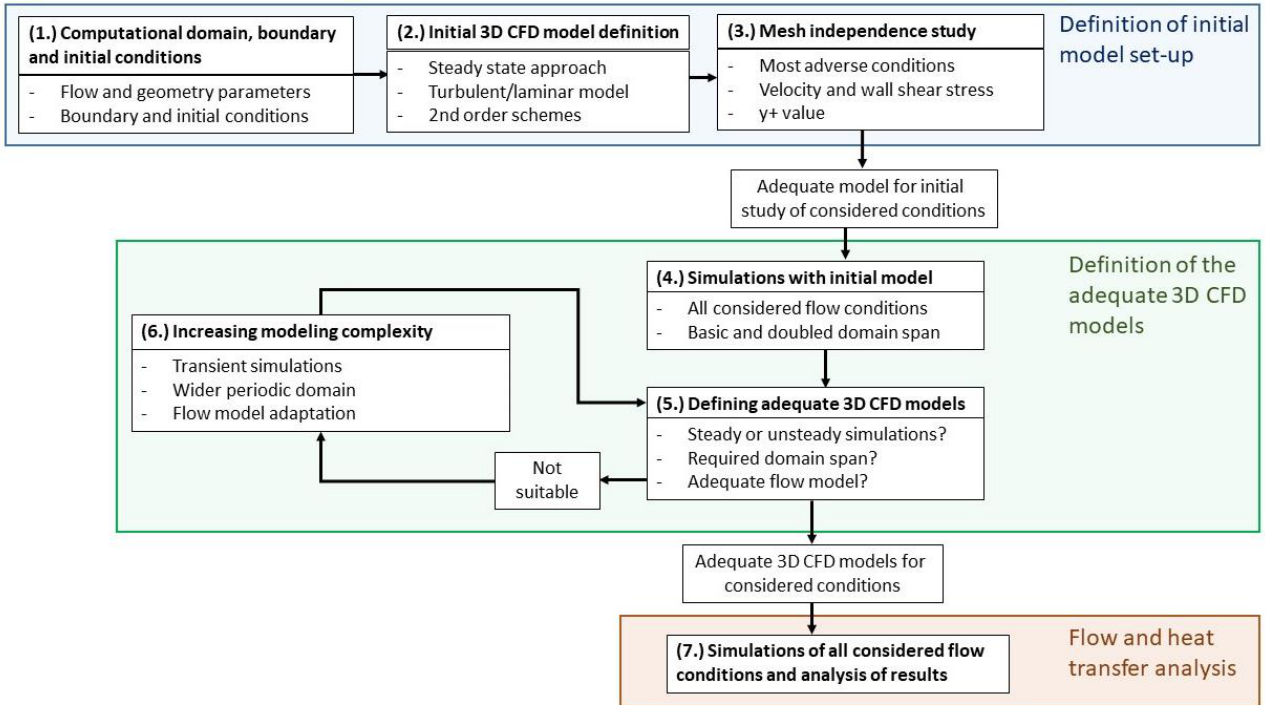
Figure 3. Schematic presentation of the workflow that was devised to obtain adequate 3D CFD models for air-gap flow simulations.